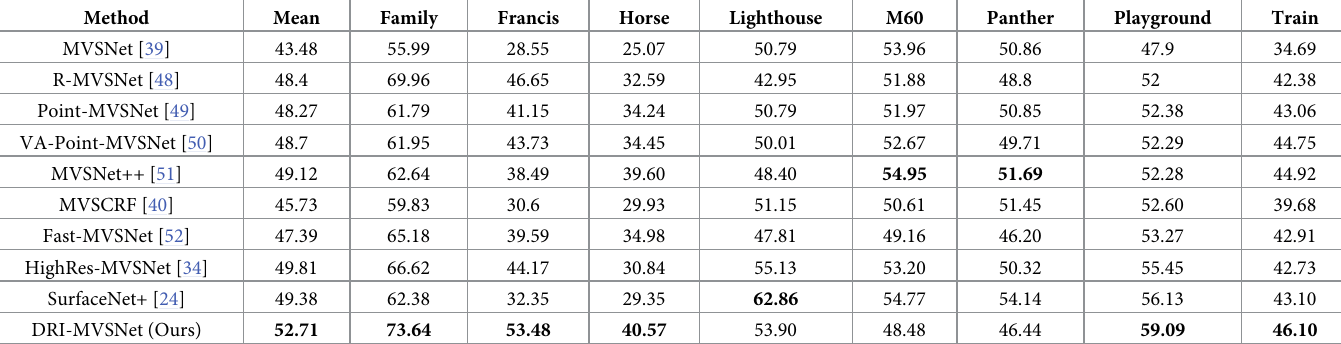
Table 3. Quantitative results on Tanks & Temples benchmark (higher is better).